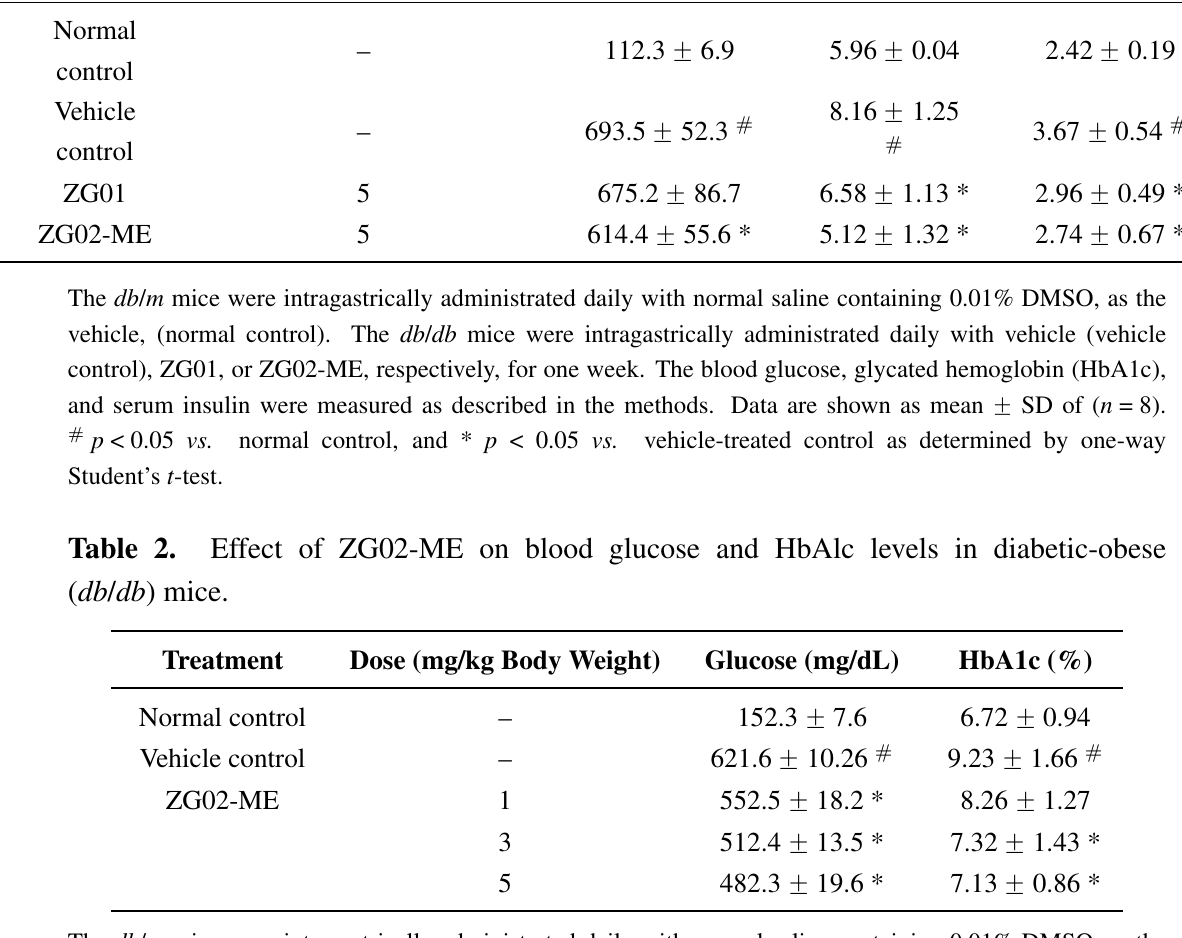
Table 1. Effect of treatment of ziyuglycosides on glucose, HbAlc, and insulin levels in diabetic-obese ( db / db ) mice.